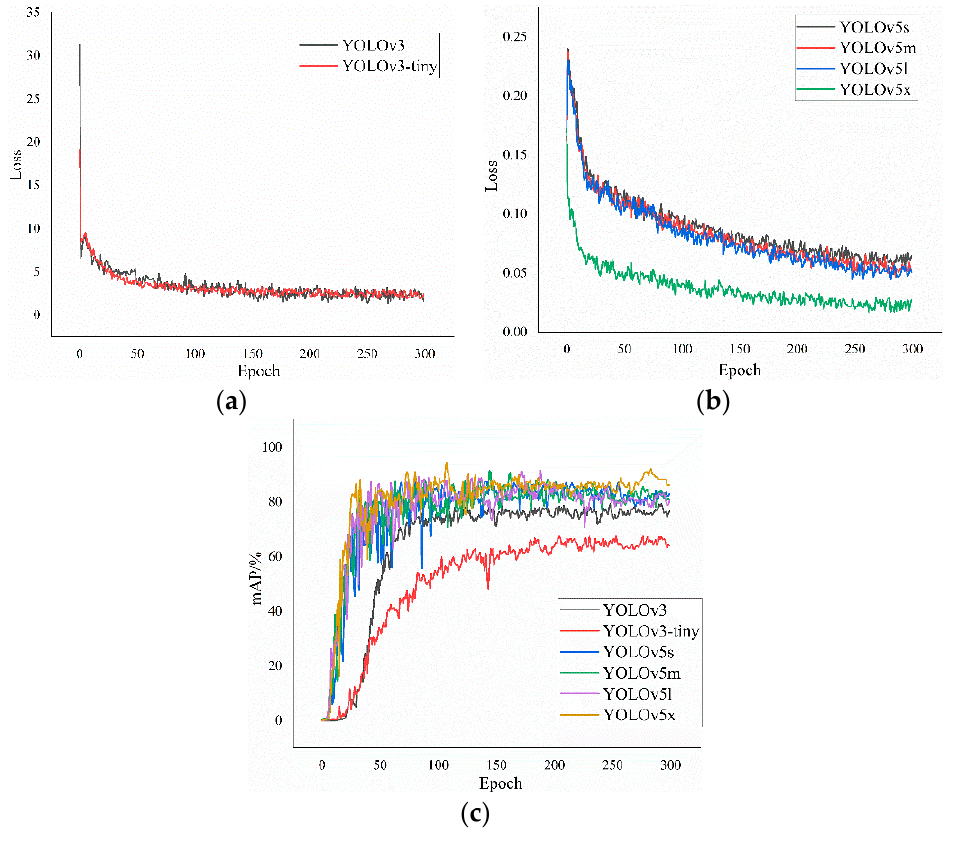
Figure 8. ( a ) The loss curve of the YOLOv3 models, ( b ) the loss curve of the YOLOv5 models, ( c ) the mAP Curve of the YOLOv3 and YOLOv5 models.